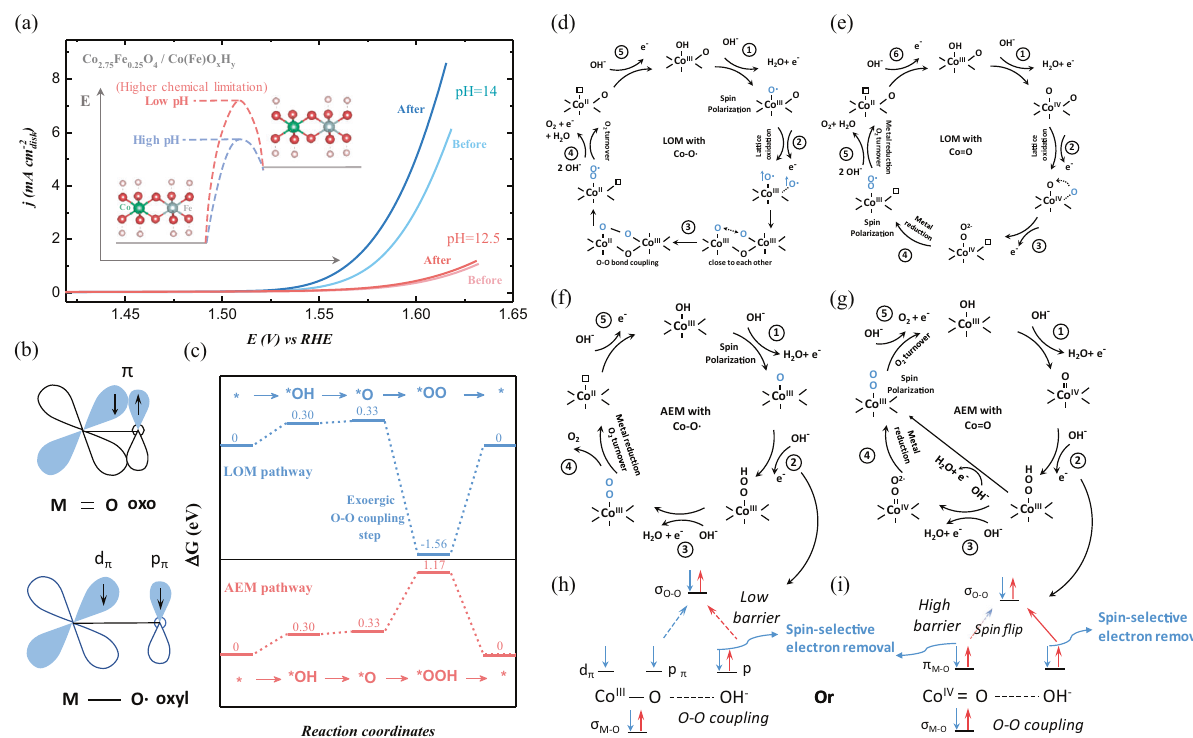
Fig. 4 Active lattice oxygen participation for producing triplet oxygen. a The linear sweep voltammetry (LSV) of the reconstructed Co 2.75 Fe 0.25 O 4 (s) (cycled in 1 M KOH for 10 cycles to evolved Co 2.75 Fe 0.25 O 4 /Co(Fe)O x H y ) before and after magnetization in magnetic fi eld of 0.5 T for 15 min under pH of 12.5 and 14. The inset is a schematic illustration of dehydrogenation under different pH for generating negatively charged oxygen on Co site. b The spin con fi gurations of M = O oxo and M-O ∙ oxyl species. c The free energy diagram of OER under AEM and LOM pathways at 1.23 V (vs. RHE) on β -Co(OOH) (001) slabs toward triplet oxygen production. d , e The LOM OER pathway for the spin polarization mechanism d with Co-O ∙ oxyl radical and e with Co = O oxo species. The early spin polarization mechanism is closely associated with the creation of oxyl radicals. f , g The adsorbate evolution mechanism (AEM) OER pathway for the spin polarization mechanism f with Co-O ∙ oxyl radical and f with Co = O oxo species. h , i The spin-related O-O coupling process under AEM h with Co-O ∙ oxyl radical and i with Co = O oxo